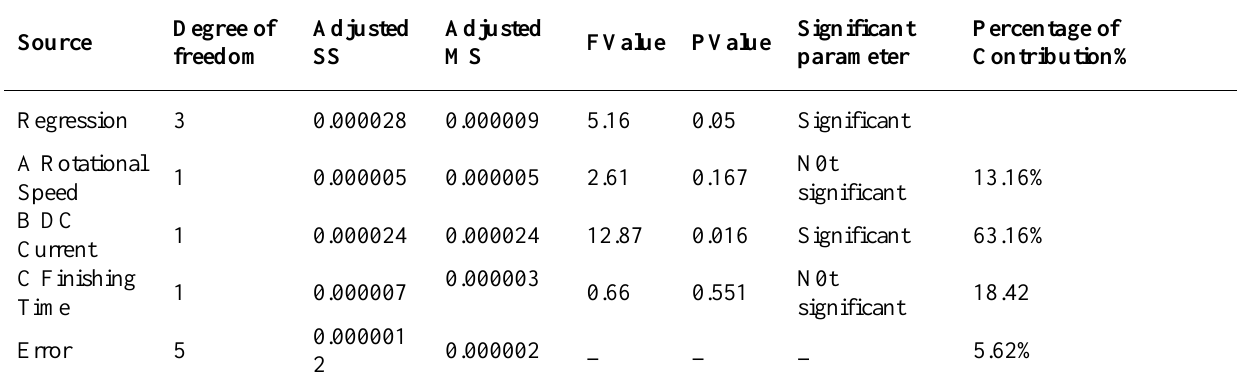
Analysis of Variance of Material Removal